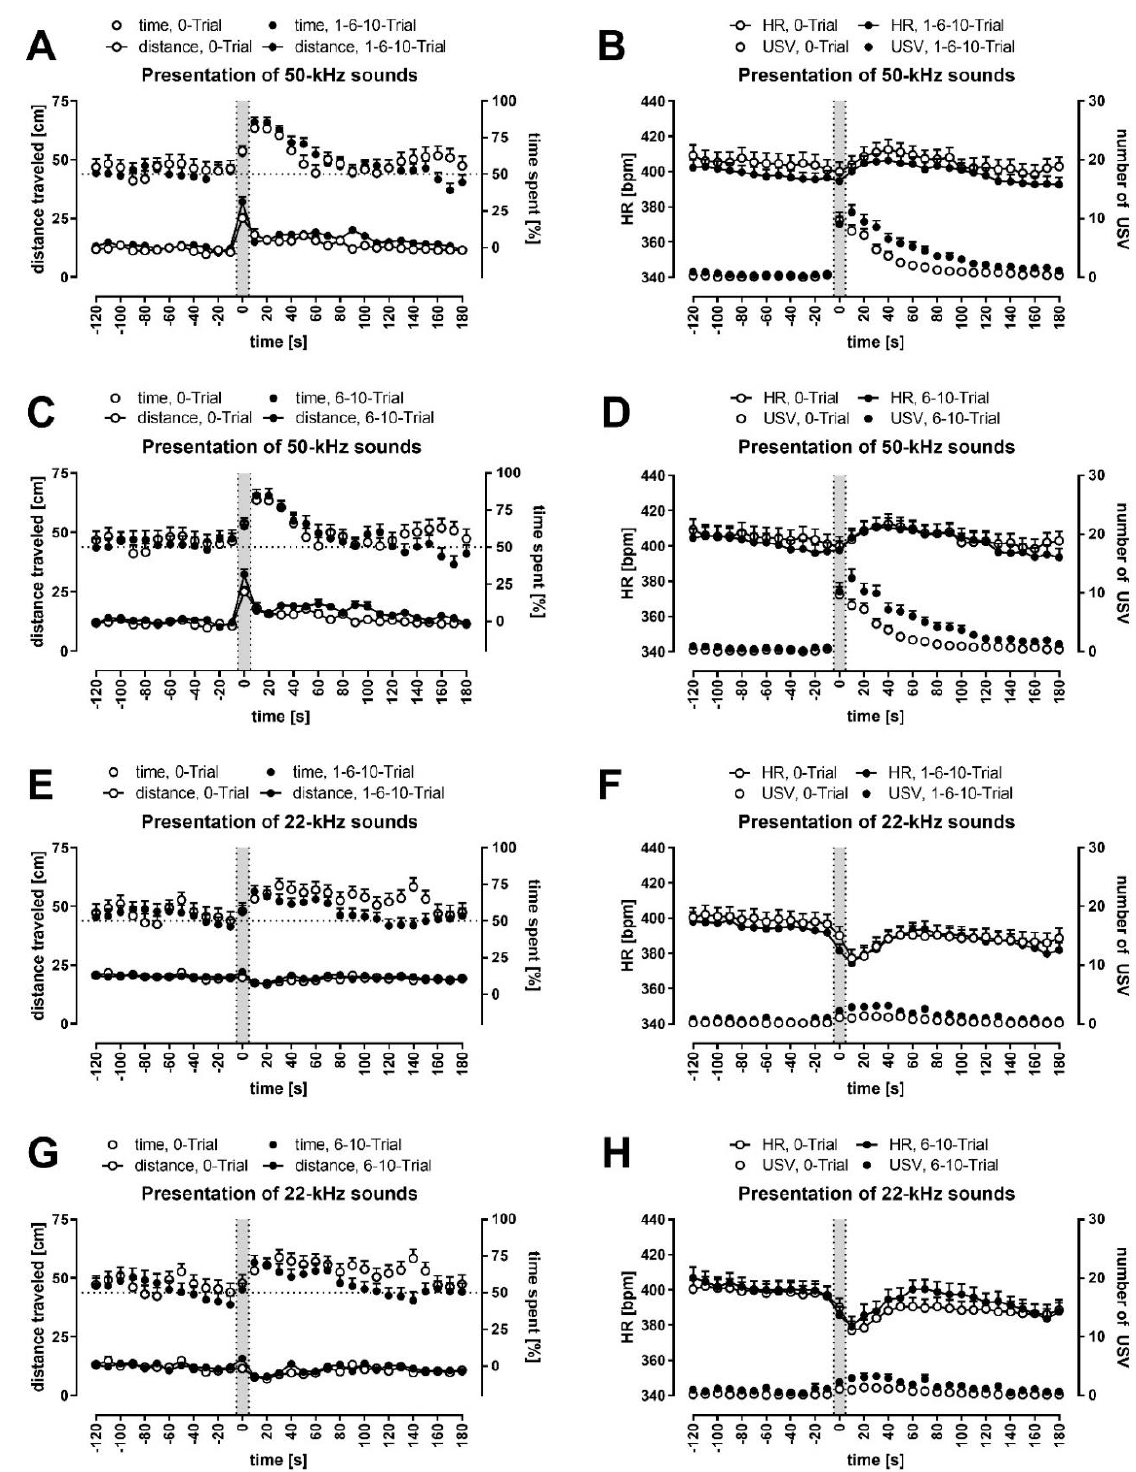
Each point is a mean for a 10-s-long time-interval with SEM. The dotted horizontal line marks a 50% chance value for time in a side of the cage. Playback of 50-kHz sounds results in a rise of locomotor activity (the weakest in control rats), copious USV emissions and HR increase (the weakest in 1-Trial rats). Playback of 22-kHz sounds is followed by decrease in locomotor activity (the smallest in 0-Trial rats) and HR as well as modest increase in vocalization; groups: 0-Trial, n = 37; 1-Trial, n = 16; 6-Trial, n = 20; 10-Trial, n = 19.